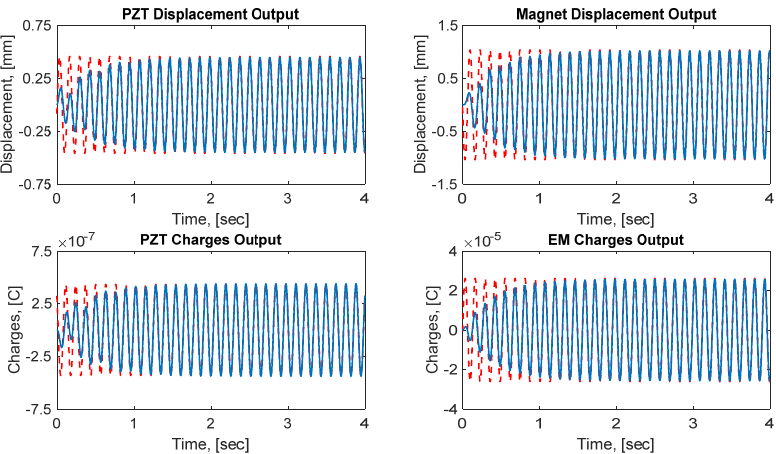
Figure 6. Steady-state analytical solution (--) versus numerical results (–) of the four generalized coordinates of the harvester. Table 1. Nominal parameters of the harvester used in this study.